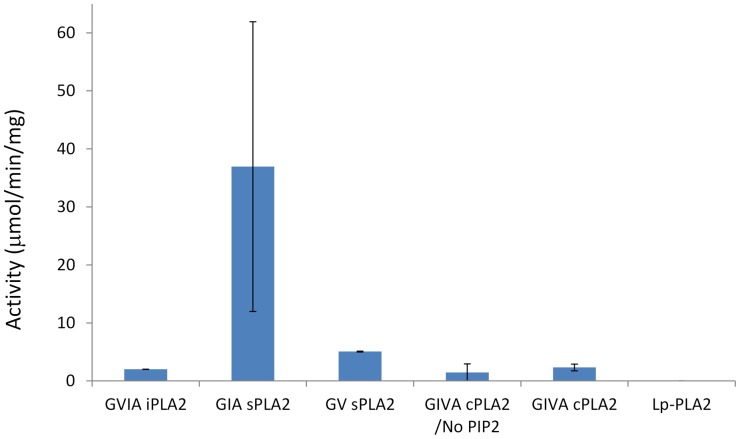
PLA2s Specific Activities toward Cardiolipin.The activities of GVIA iPLA2, GIA sPLA2, GV sPLA2, GIVA cPLA2 and Lp-PLA2, toward cardiolipin were examined by GC mass spectrometry. cPLA2 activities both with and without PIP2 activation are shown.